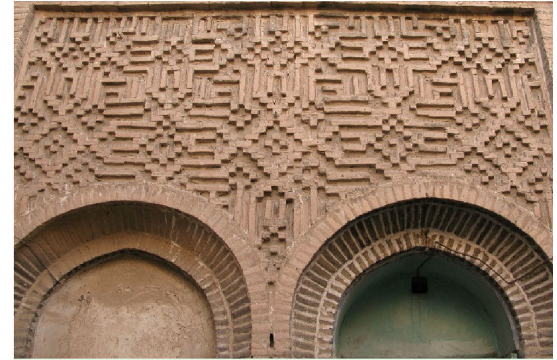
Fig. 12 Chahar-Ali-Gol-Dar Xowun in Kohinejad house. Source: MCHT of